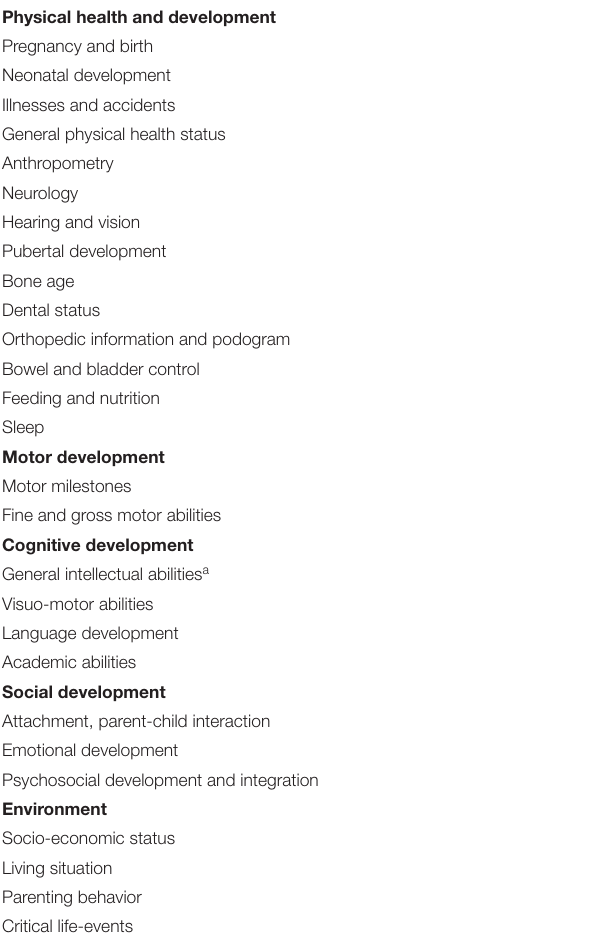
TABLE 1 | Overview of assessed domains of health and development during